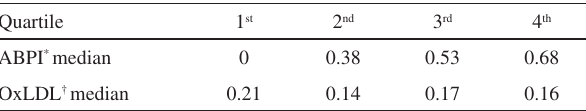
Table 2 - Median oxLDL levels per ABPI